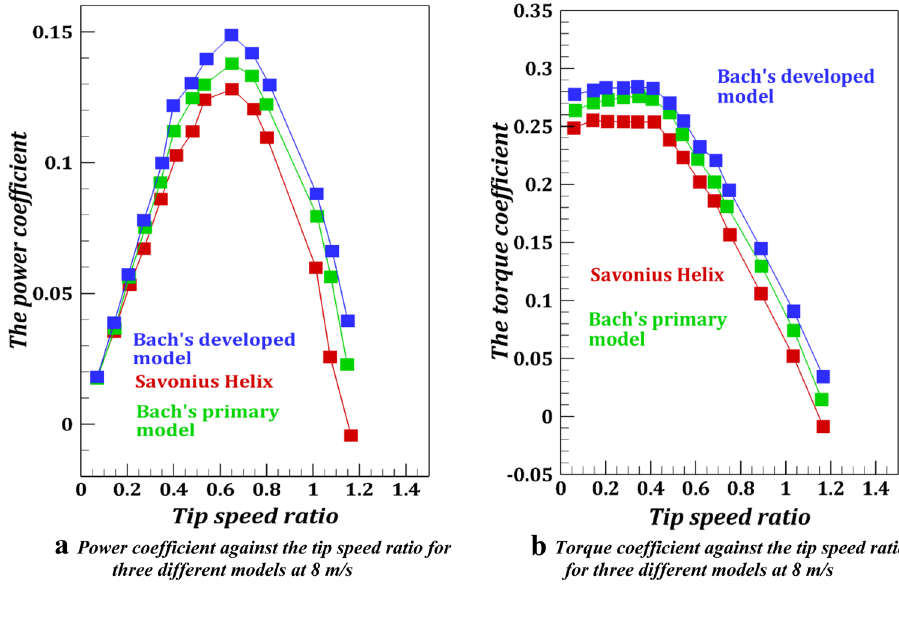
Fig. 11 a Power coefficient against the tip speed ratio for three different models at 10 m/s; b Torque coefficient against the tip speed ratio for three different models at 10